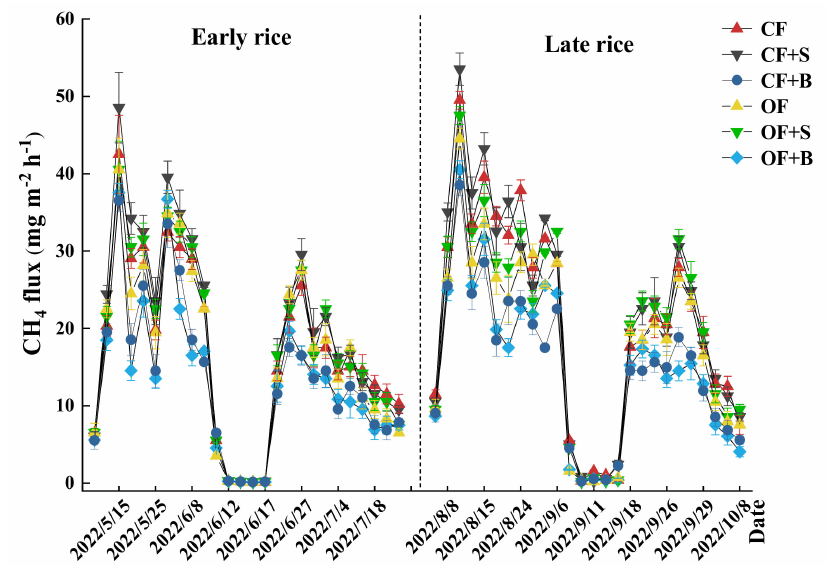
Figure 1. Seasonal variations in the CH 4 emission flux in the double rice cropping system under different treatments. Error bars represent standard deviations ( n =